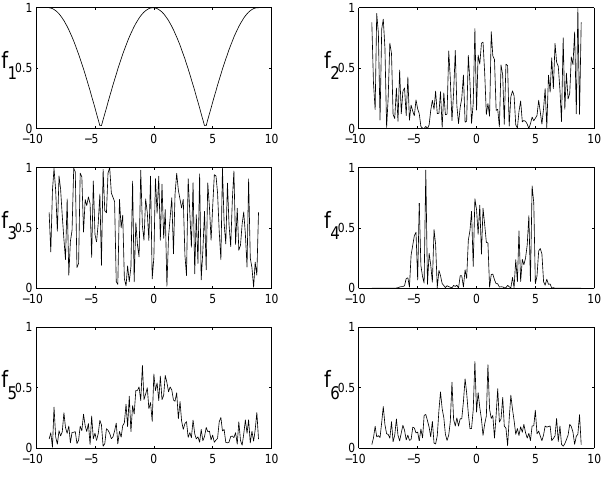
Figure 3. Initial periodic perturbations f i , i = 1 ,..., 6.